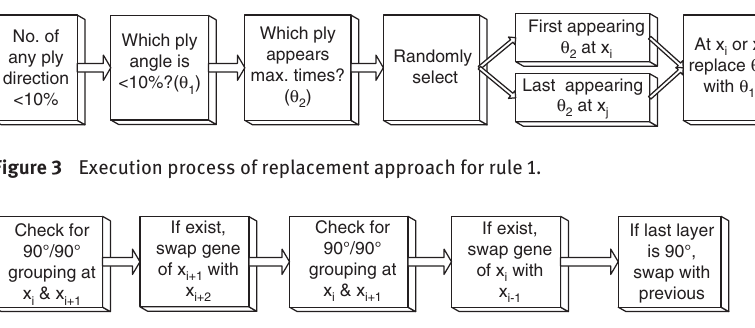
Figure 4 Execution process of swap approach for rule 5. From the flowchart, the location of replacement is not randomly selected, and the first appearing value of θ 2 is replaced with θ . It is difficult to assume how many 1 times θ will appear in a string. Thus, to randomly 2 select a locus that contains θ is also difficult. In order 2 to simplify, the randomization of locus selection for replacement is limited between the first appearing θ 2 and last appearing θ . However, the randomness is 2 still available, because the x and x are not fixed locus i j on the chromosome string and either of them is ran- domly